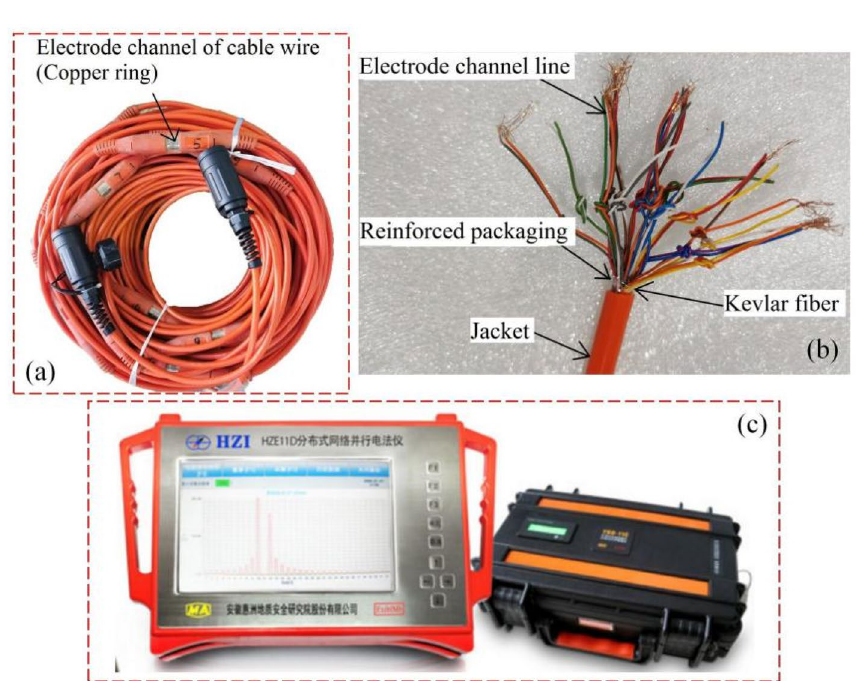
Figure 3. Geoelectric field monitoring equipment. ( a ) Electrical cable, ( b ) electrical cable structure details, ( c ) parallel electrical